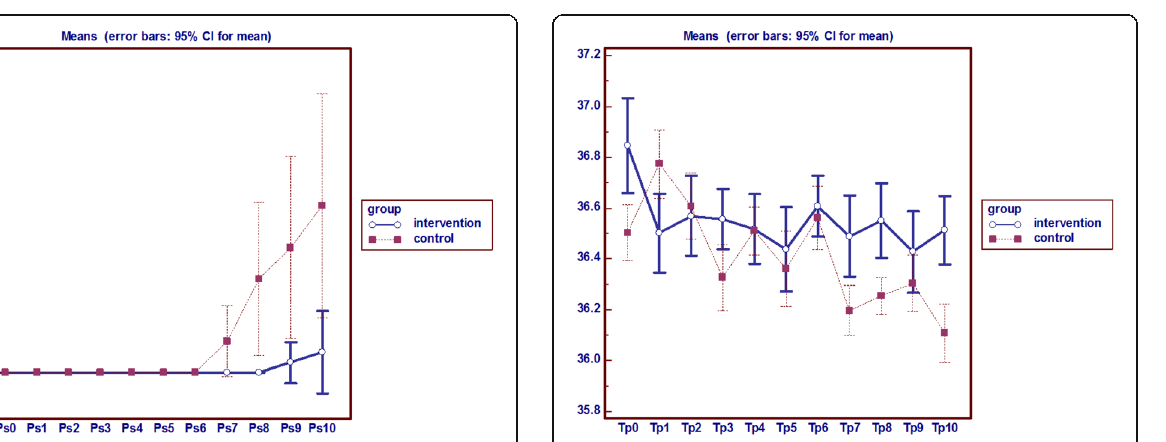
Fig. 6 Analysis of variance with repeated measures on the heel temperature